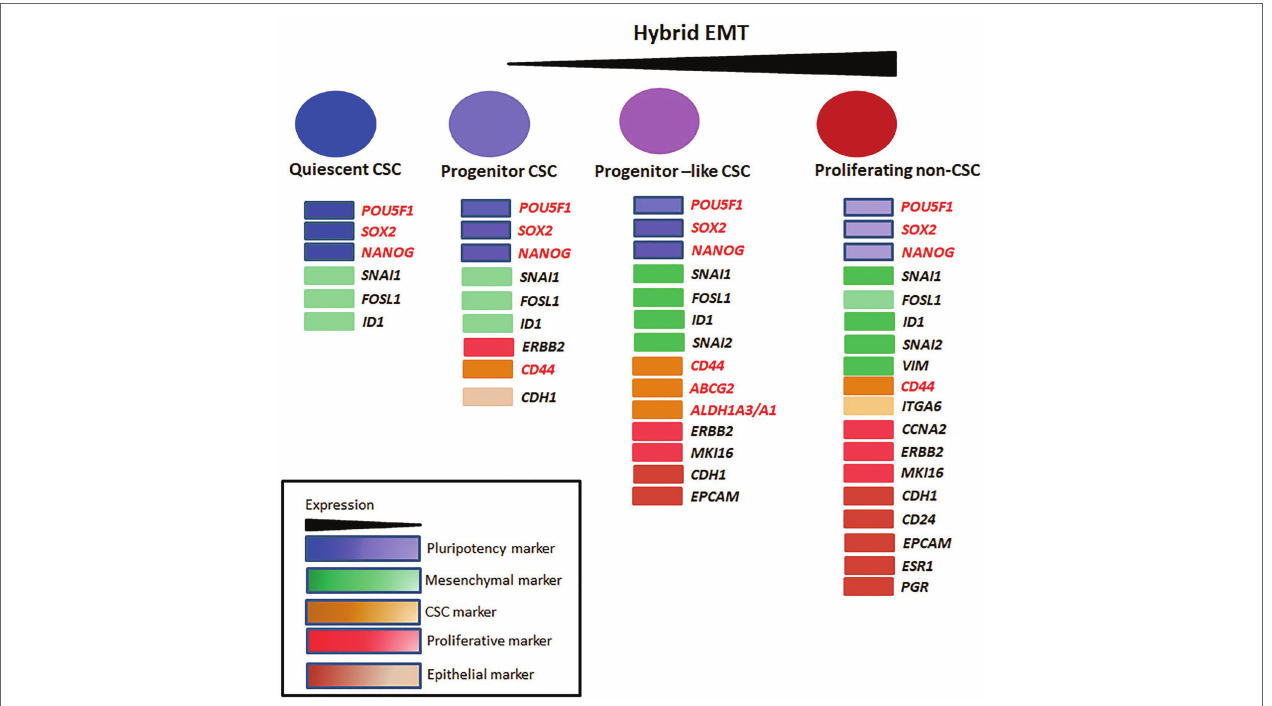
FIGURE 1 | The heterogeneity in cancer stem cells (CSCs). The different populations identified in breast CSCs and their markers are represented. The non-dividing Quiescent population, Progenitor population, Progenitor-like population, and the differentiated non-CSC population express a gradient of pluripotent, mesenchymal/ epithelial and proliferative markers. The Quiescent population expresses a high level of pluripotent transcriptional factors and a moderate level of mesenchymal markers. With differentiation, the level of pluripotent markers comes down. The Progenitor population starts to express proliferative markers, CD44 and epithelial markers in very low levels. The Progenitor-like population co-expresses mesenchymal and epithelial markers manifesting a gradual increase in hybrid-epithelial- mesenchymal transition (EMT) phenotype. This population also expresses CSC markers ALDH1A1/A3 and ABCG2 contributing to drug-resistance. Non-CSCs lose the expression of pluripotent and other CSC markers except for CD44. The proliferative markers, epithelial markers, and mesenchymal markers are at maximum expression level in this population. This population can metastasize, but cannot initiate tumor until they dedifferentiate into